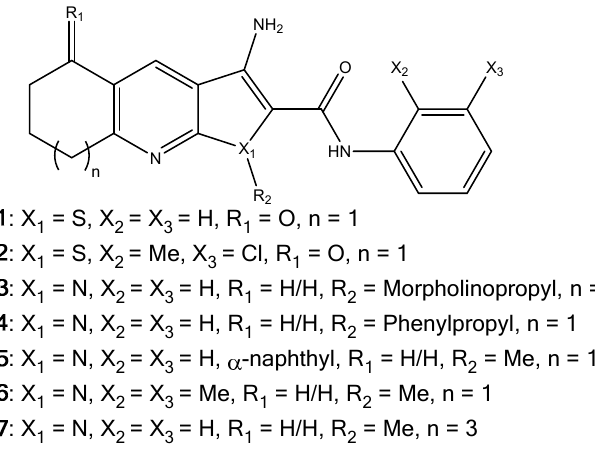
Figure 2. The molecular structures of the thieno[2,3- b ]pyridines ( 1 , 2 ) and 1 H -pyrrolo[2,3- b ]pyridines ( 3 – 7 ).